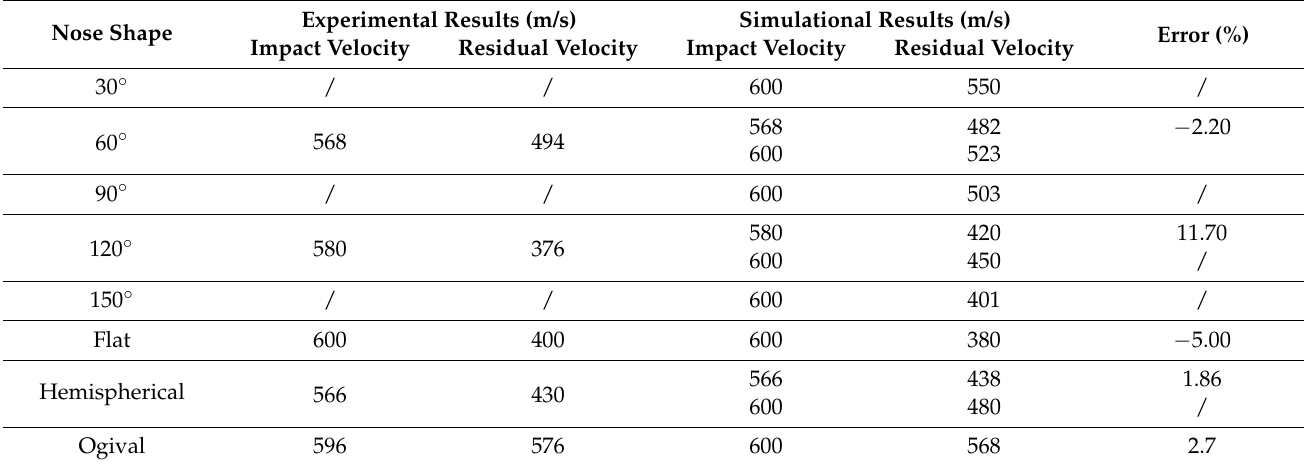
Table 5. The residual velocity of the projectiles in experiments and simulations.